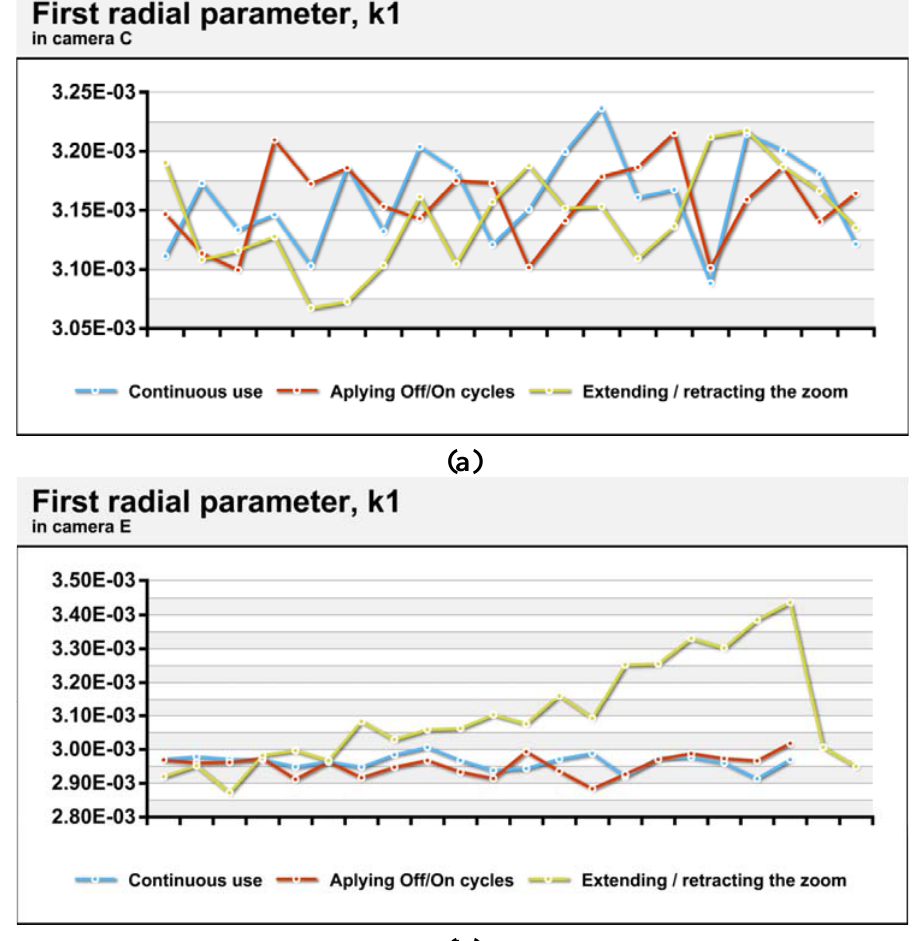
Figure 6. First radial distortion parameter obtained in camera C (a) and E (b) for the 372 calibrations done continuously, by power cycling and after the extension/retraction of the zoom